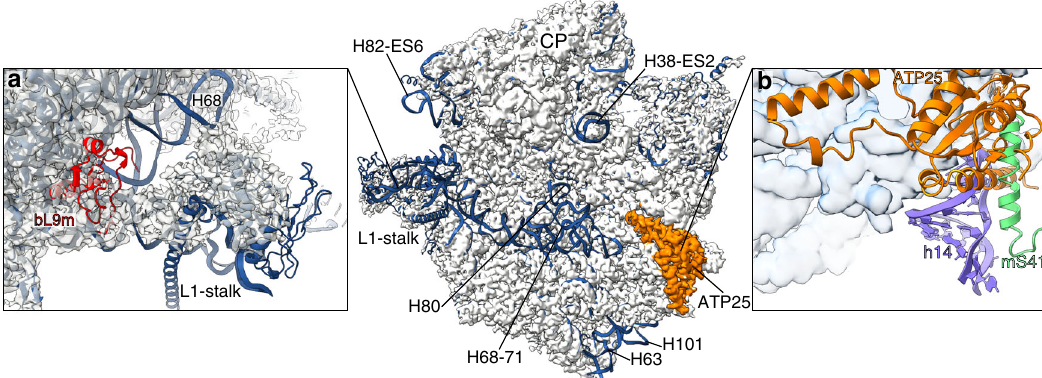
Fig. 6 Structure and function of the mtLSU-Atp25 assembly complex. Superposition of the assembly intermediate cryo-EM map (gray) with the mature mtLSU model (blue) reveals unfolded interfacial rRNA. a conformational change of the L1 stalk, missing bL9m (red). b presence of Atp25 (orange) that would clash with the mtSSU h14 and mS41, preventing subunit association.